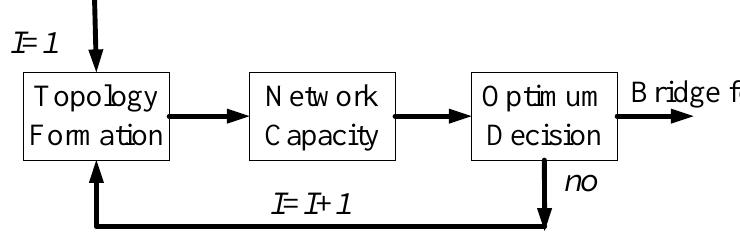
Figure 5. Block diagram of the peak-search method.